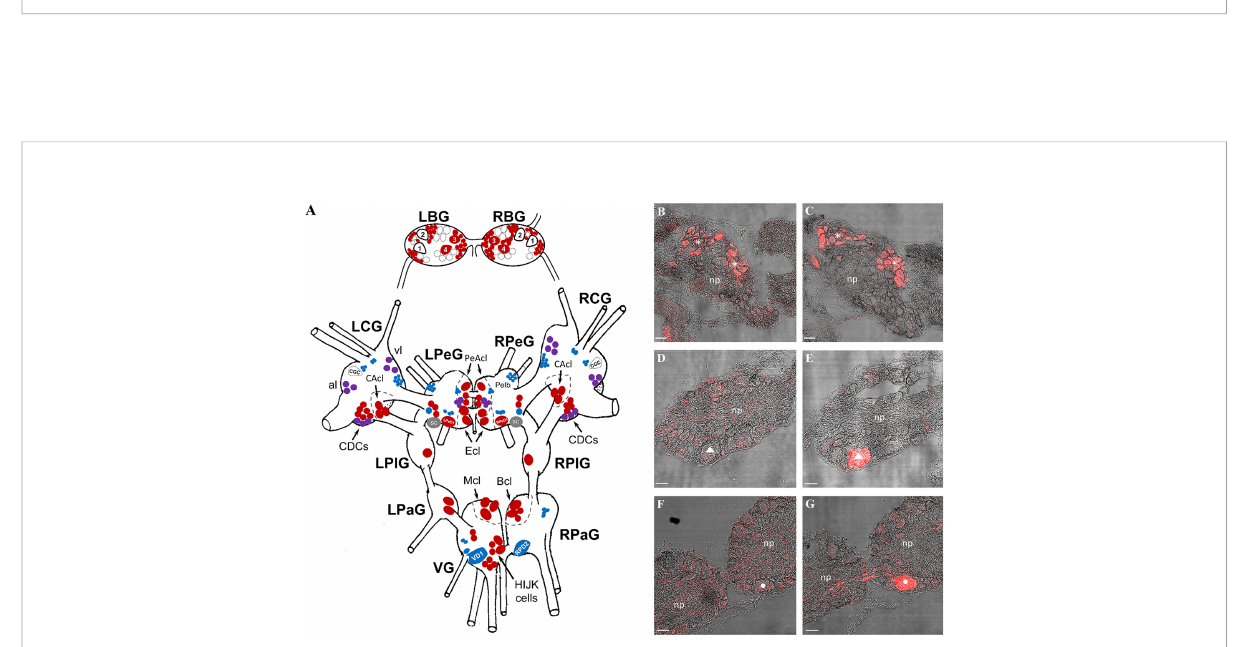
FIGURE 4 Immunolabeling by the speci fi c anti-ly-GnRH/CRZ antibody [the antigen was a synthetic undecapeptide [CNYHFSNGWYA-amide] corresponding to ly-GnRH/CRZ (49, 52 – 54)] and/or the non-speci fi c anti-human GnRH antibody (the antigen was a synthetic decapeptide [pQHWSYGLRPG-amide] corresponding to human GnRH) in the CNS. (A) Schematic CNS map (dorsal view) showing the distribution of neurons labeled in the left and right buccal (BG), cerebral (CG), pedal (PeG), pleural (PlG), parietal (PaG), and visceral (VG) ganglia. Neurons labeled by the speci fi c, the non-speci fi c, and both antibodies are indicated with red, blue, and purple symbols, respectively. Some unlabeled but identi fi ed large neurons (e.g., CGC) are included for providing reference points for anatomical orientation. (B-G) Representative micrographs made by alternating sectioning showing the comparative immunolabeling (red). In the right CG (B, C) , both speci fi c (B) and non-speci fi c (C) antibodies yielded a signal, in part the same neurons were labeled (indicated by asterisks). The giant VD1 neuron (marked by a triangle) of the VG (D, E) and the giant RPD2 neuron (marked by a circle) of the right PaG (F, G) were labeled only by the non-speci fi c antibody (E, G) . Scale=50 µm. B1-B4, identi fi ed buccal feeding motoneurons; CGC, cerebral giant cell; CDCs, caudo-dorsal cells; al, anterior lobe; vl, ventral lobe; LPeD1, left pedal dorsal 1 neuron; RPeD1, right pedal dorsal 1 neuron; CAcl, cerebral A-cluster; PeAcl, pedal A-cluster; Ecl, E-cluster; SC, statocyst; Mcl, M- cluster; Bcl, B-cluster; VD1, visceral dorsal 1 neuron; RPD2, right parietal dorsal 2 neuron; np,